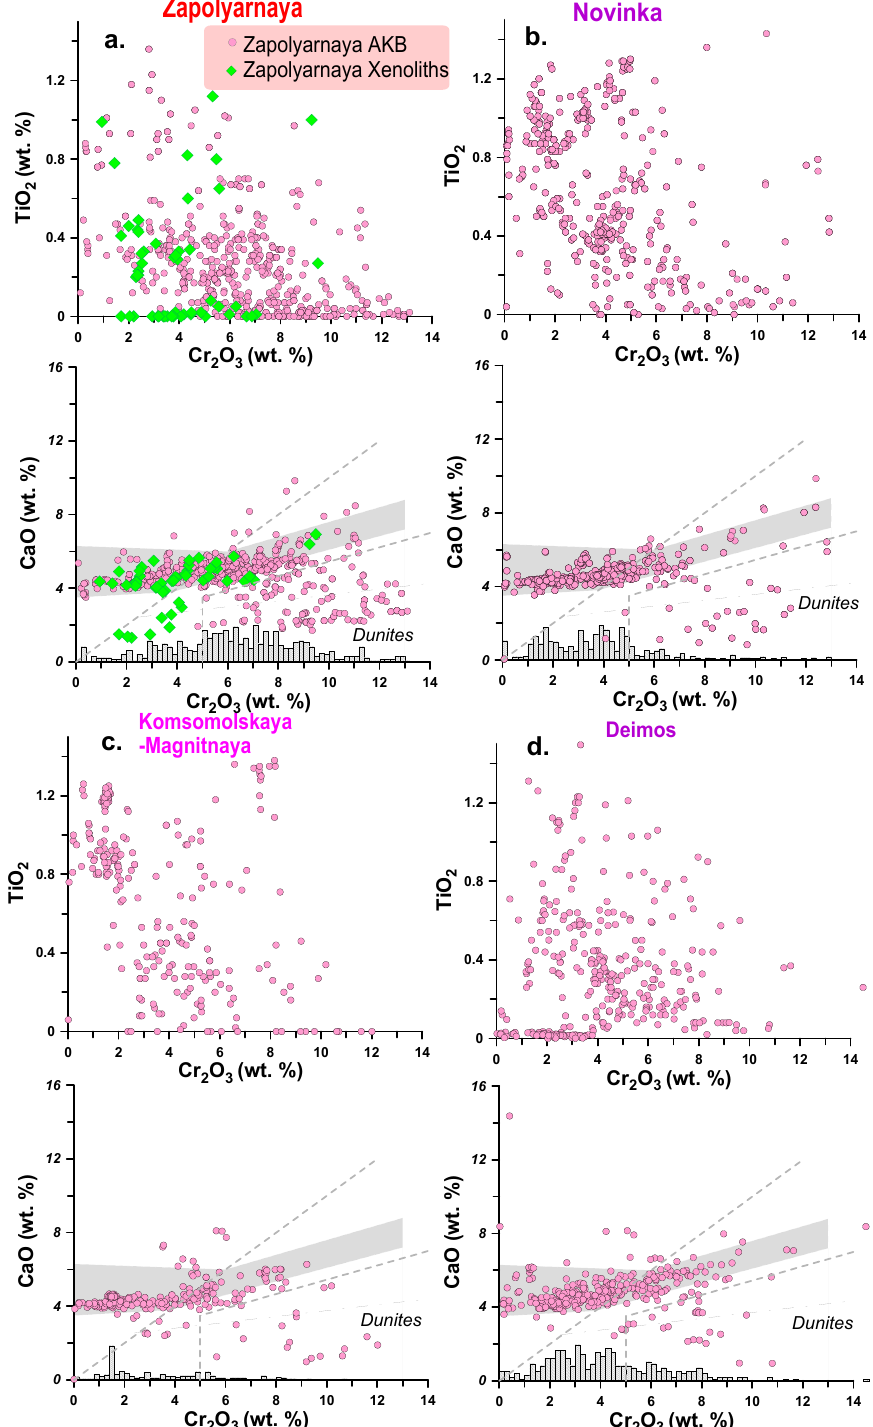
Figure 5. Compositions of Cr-garnets from Upper Muna (xenolith and concentrate) ( a ) Zapolyarnaya; ( b ) Novinka; ( c ) Deimos, ( d ) Komsomolskaya-Magnitnaya. Data for Novinka, Deimos, and Komsomolskaya-Magnitnaya are partly published [12]. Grey field for lherzolites. The dashed line is for diamond association [1]. The dotted-dashed line divides dunite associations. The histograms show wt.% Cr 2 O 3 and use the same axes. Data are from this study and from previous publications [11,12]. Clinopyroxenes from the xenoliths of the Zapolyarnaya pipe show a variation in FeO from 1 to 6 wt.% and have nearly constant Al 2 O 3 around 1.5–2.5 wt.% (Figure 6a). Only a few Cpx close to